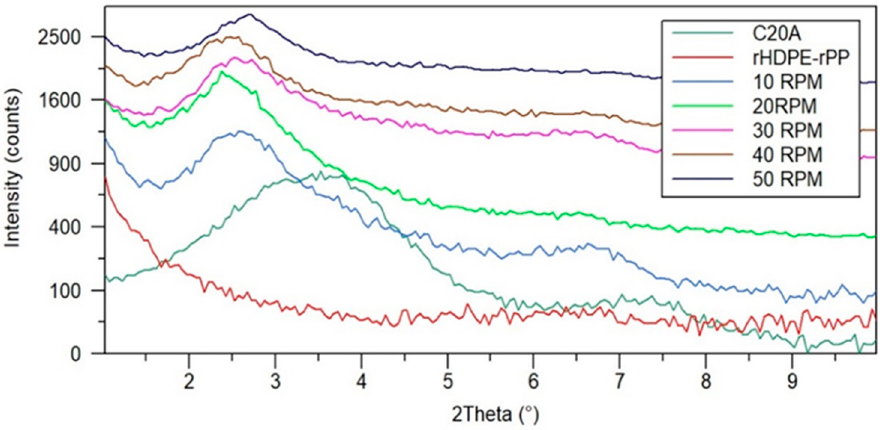
Figure 5. X-ray diffractometry of the 92% rHDPE/rPP, 3% C20A, and 5% OBC blend at different screw speeds, JCPDS-Card No. #00-007-0330.